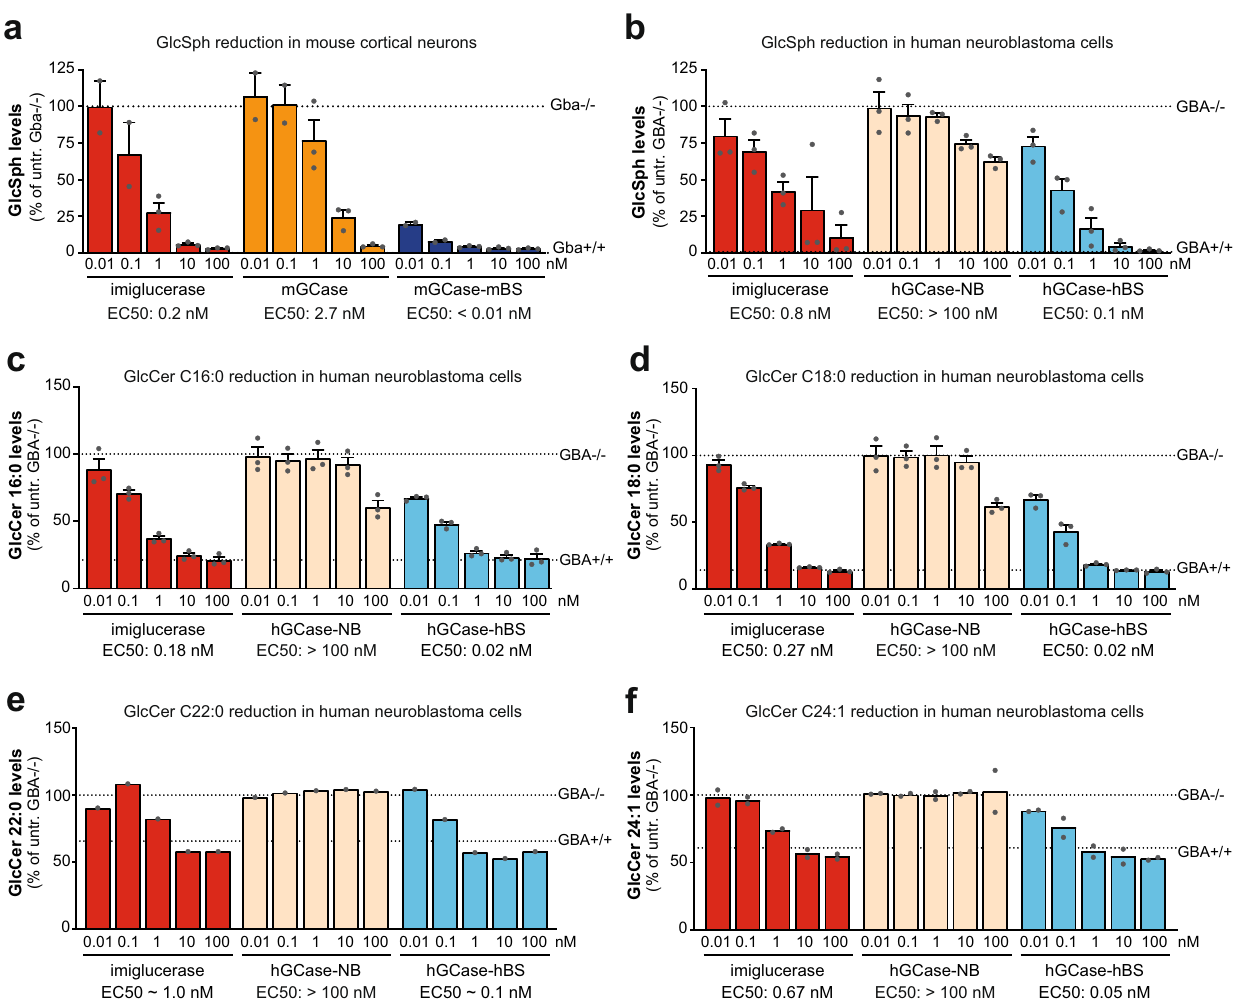
Fig. 3 | The Brain Shuttle module improves the breakdown of GlcSph and multiple GlcCer isomers in vitro. a GlcSph measurement in mouse cortical neu- rons asa measureofef fi cacy after48h oftreatment with imiglucerase, mGCase or mGCase-mBS.Datawasnormalisedto Gba − / − cells. n =3. b GlcSphmeasurementin H4cellsasameasureofcatalyticef fi cacyafter48hoftreatmentwithimiglucerase, hGCase-NB or hGCase-hBS. Data was normalised to GBA − / − cells. n =3. c GlcCer C16:0 measurement in H4 cells as a measure of catalytic ef fi cacy after 48h of treatment with imiglucerase, hGCase-NB or hGCase-hBS. n =3. d GlcCer C18:0